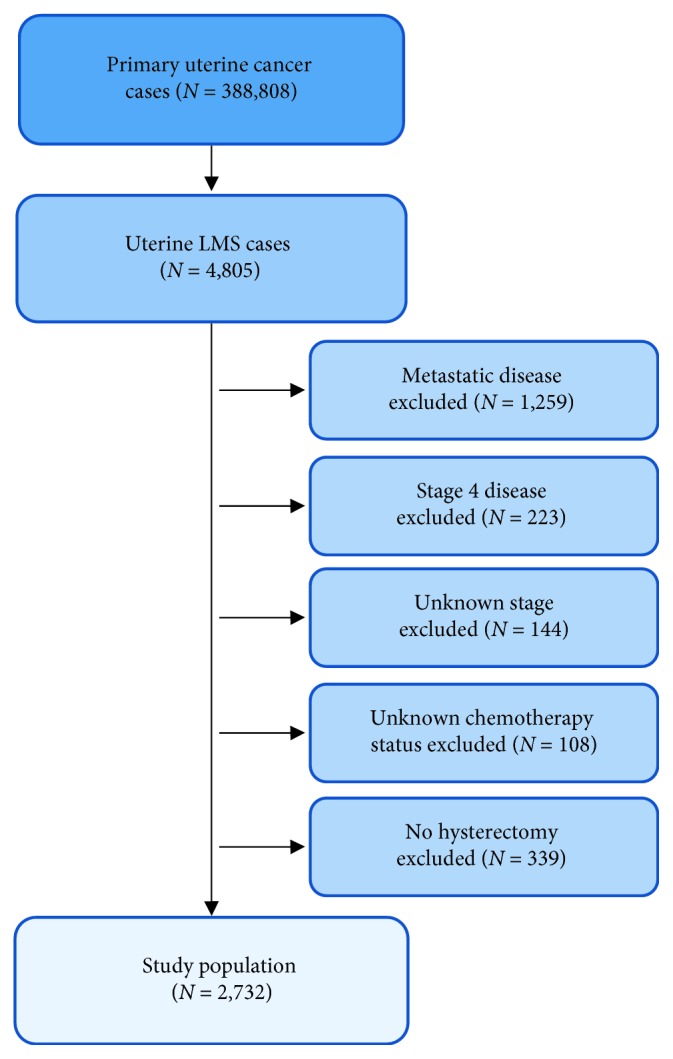
Consort flow diagram used for inclusion and exclusion of patients in this study.